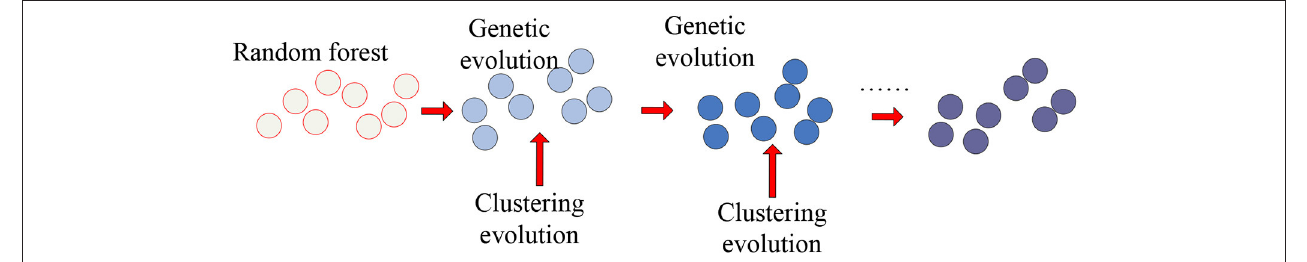
FIGURE 1 | The schematic diagram of clustering genetic random forest.